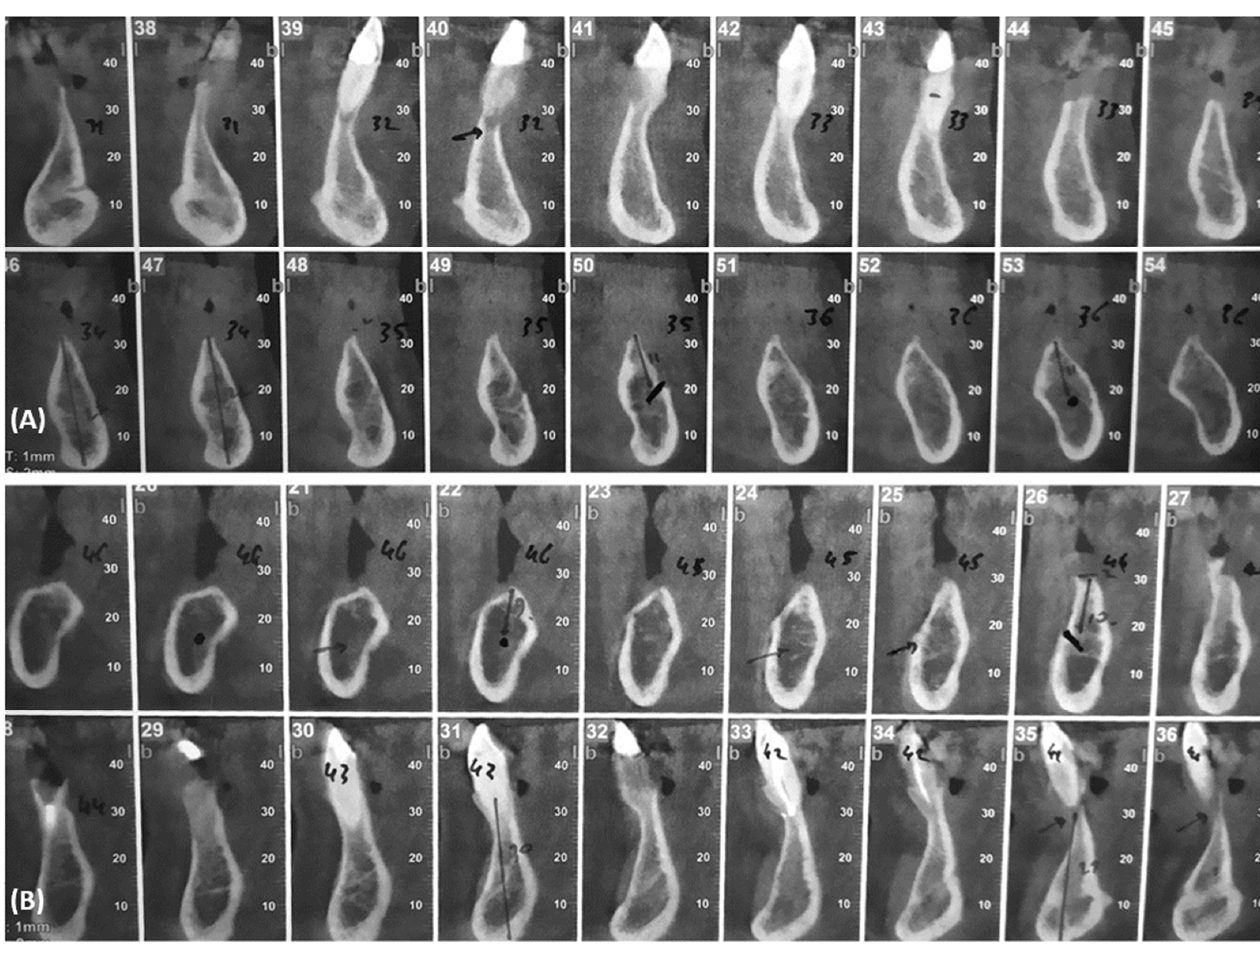
Figure 3. Tc cone bean. ( A ) Left side. ( B ) Right side (February 2020).